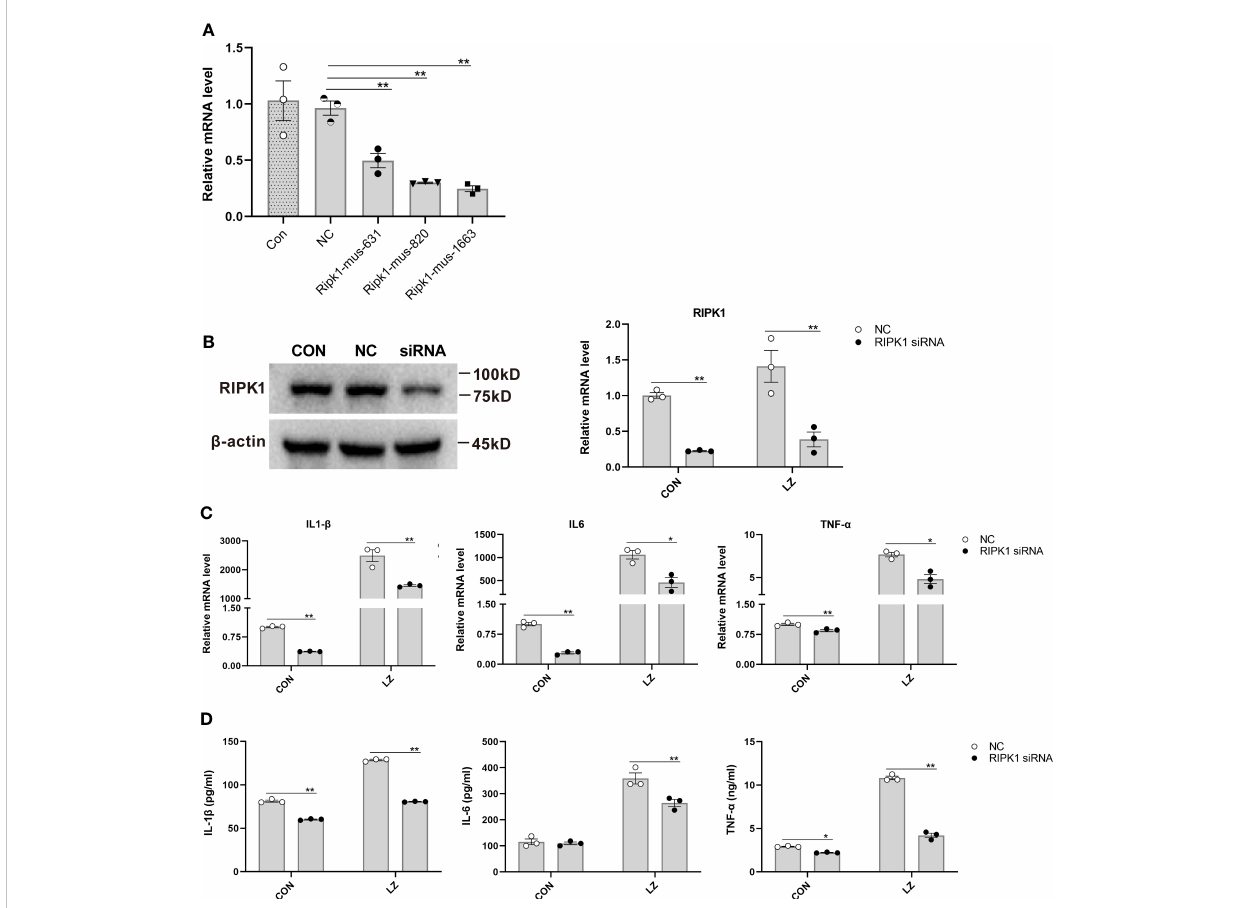
FIGURE 6 The effect of RIPK1 knockdown on in fl ammatory cytokines induced by LZ in RAW 264.7 cells. (A) The effect of different siRNA sequences on RIPK1 knockdown was measured by qRT − PCR. Means ± SEs, n=3, * P < 0.05, ** P < 0.01, vs. NC (negative control transfected cells). (B) RIPK1 knockdown in RAW 264.7 cells with the Ripk1-mus-1663 sequence siRNA was con fi rmed by Western blot. The low expression of RIPK1 in the LZ model was measured by qRT − PCR. (C) The effect of RIPK1 knockdown on IL-6, IL-1 b and TNF- a induced by LZ in RAW 264.7 cells was measured by qRT − PCR. (D) The effect of RIPK1 knockdown on IL-6, IL-1 b and TNF- a induced by LZ in RAW 264.7 cells was detected by ELISA. Means ± SEs, n=3, * P < 0.05, ** P < 0.01, vs.